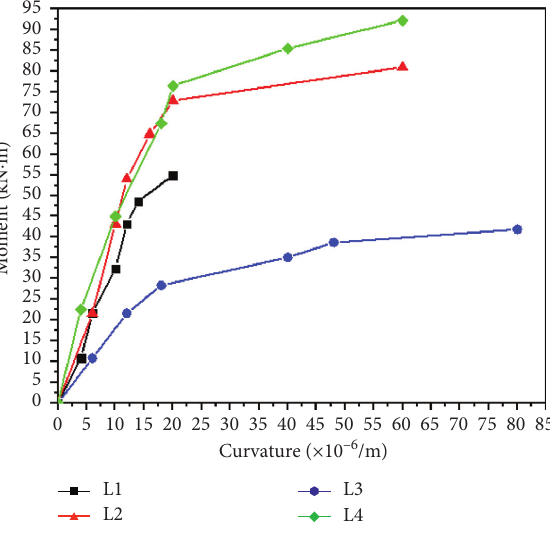
Figure 11: Bending moment curvature diagram of